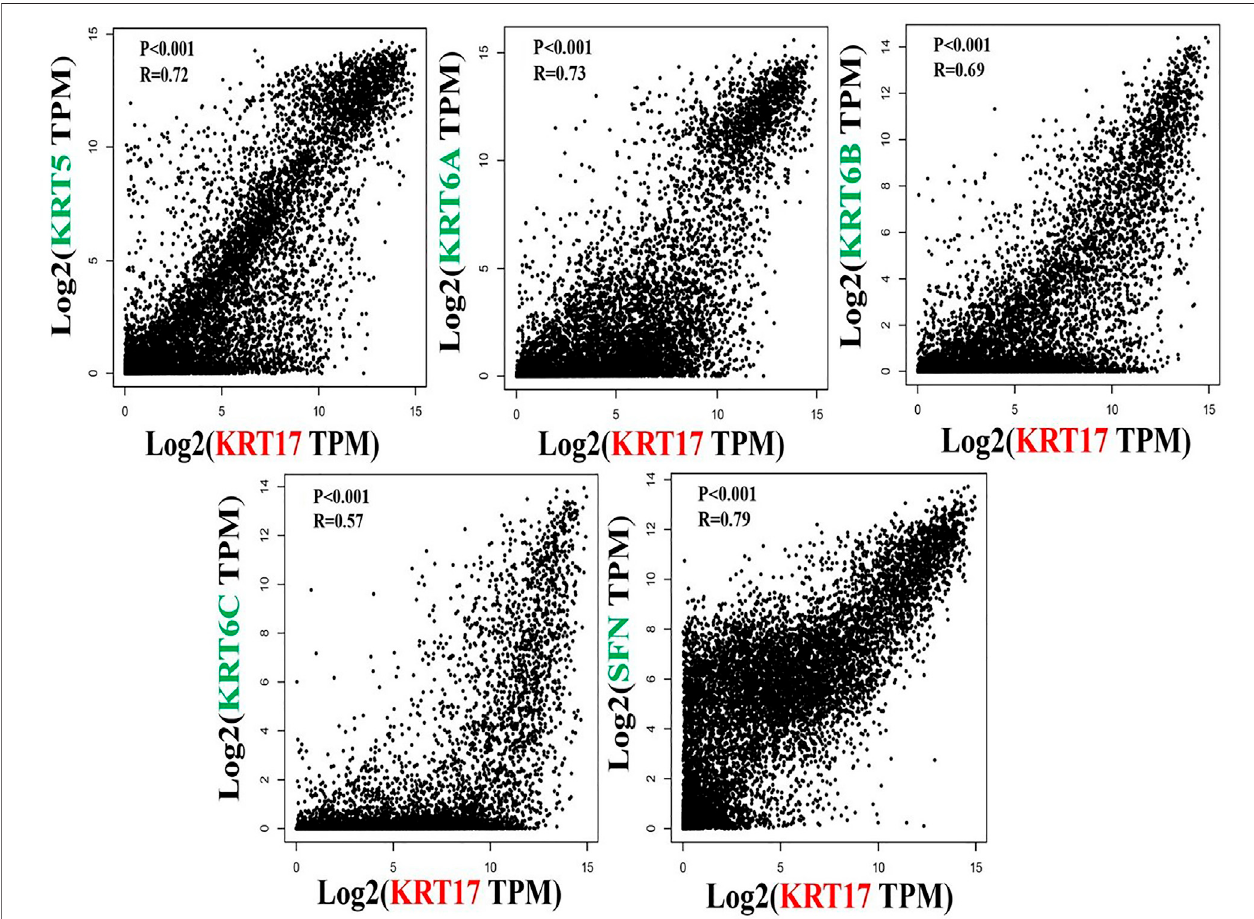
FIGURE13| Correlation betweenKRT17andKRT5,KRT6a,KRT6b,KRT6candSFN.Theresultsshowedthattheexpression ofKRT17waspositivelycorrelated with the expression of KRT5, KRT6a, KRT6b, KRT6c and